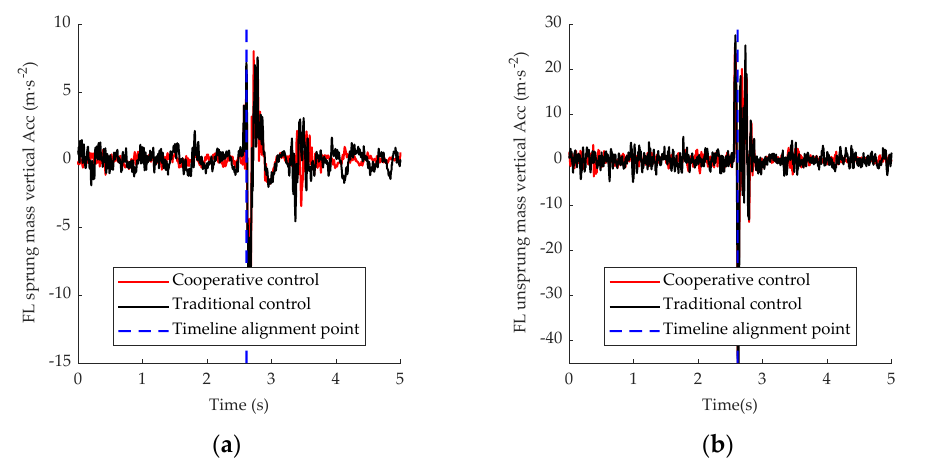
Figure 11. Comparison of cooperative and traditional control under bump condition. ( a ) Front-left